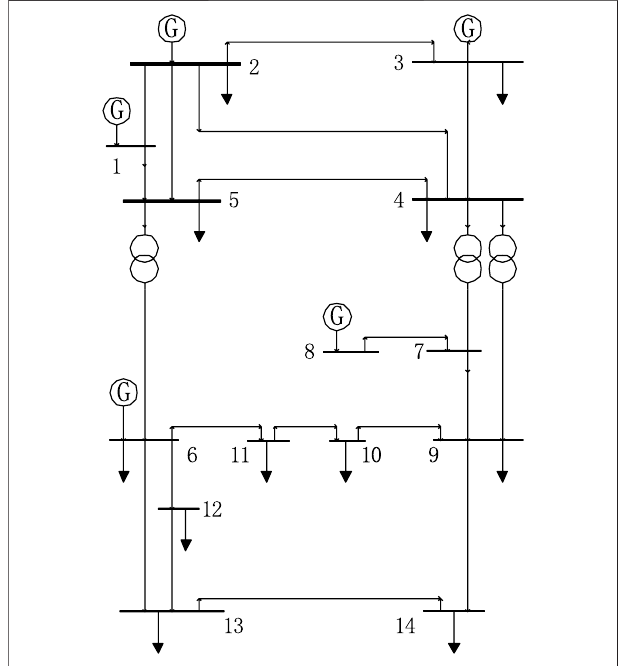
FIGURE 3 | IEEE-14 buses standard system network